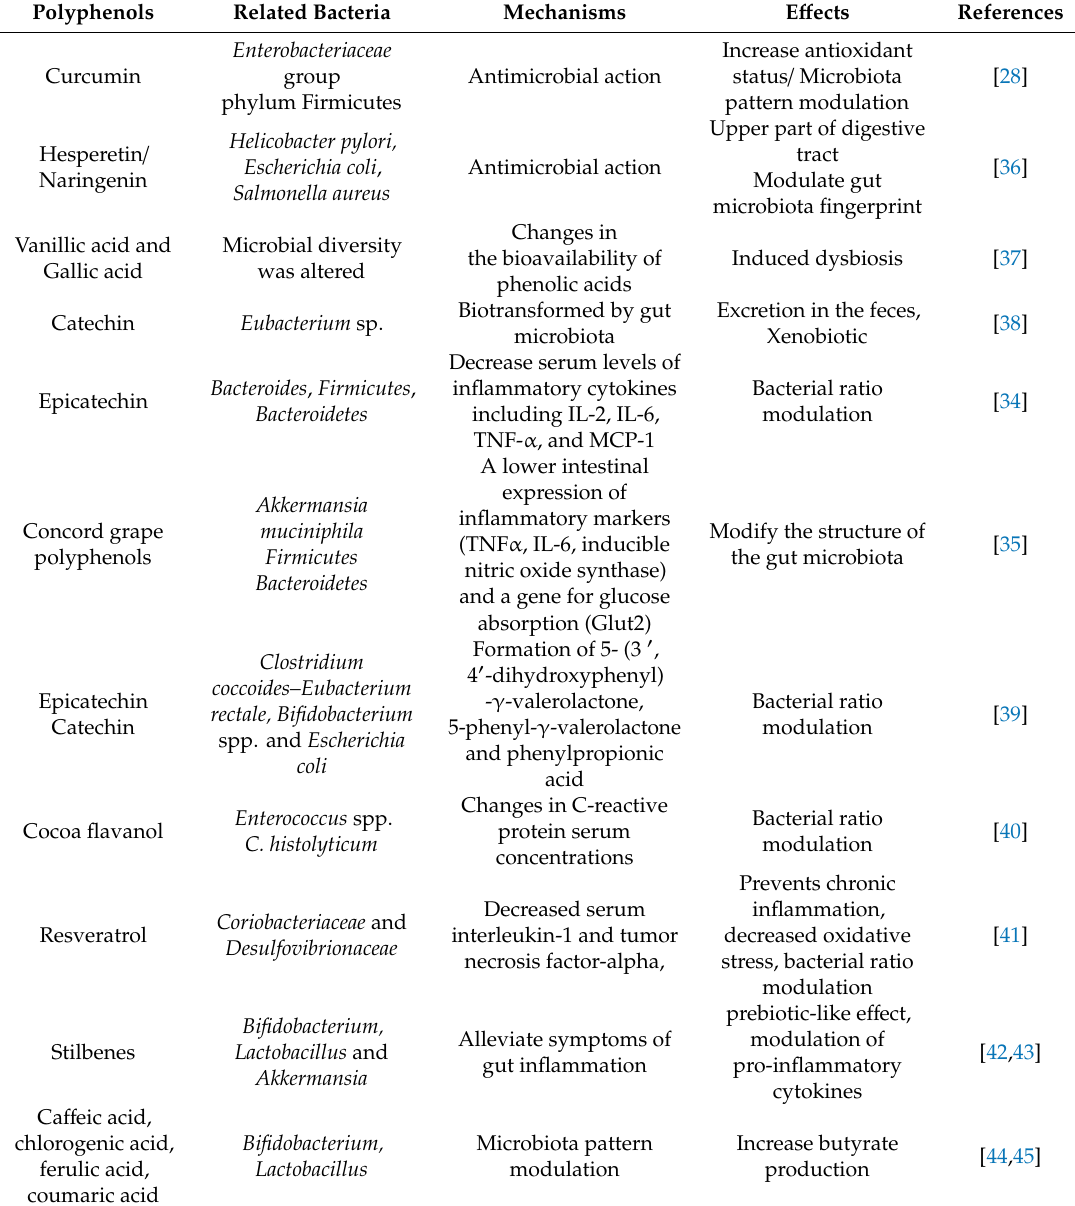
Table 1. The interaction between the microbiota and